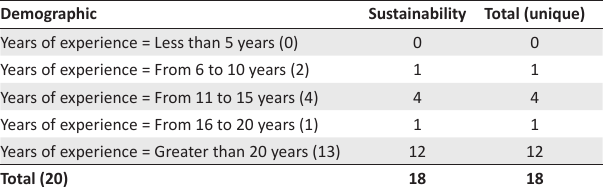
TABLE 1: Crosstabulation – Sustainability and experience (Nvivo™/®/© version 12). Demographic Sustainability Total